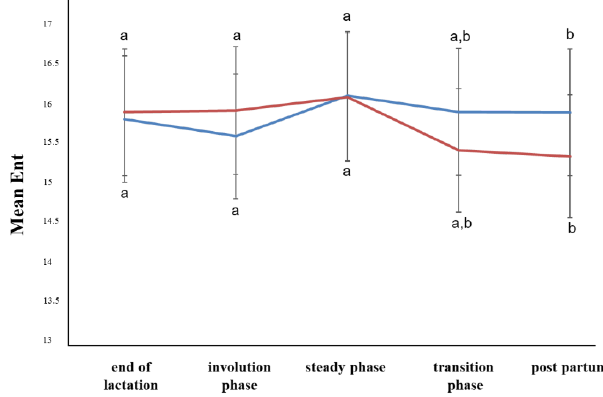
Figure 2. Entropy changes among the periods and between the ewe groups ( p ≤ 0.05). The different letter indicators (a, b) represent statistically significant differences between the periods. The blue line represents the ewe group with healthy udders, while the red represents the ewe group with subclinical mastitis.